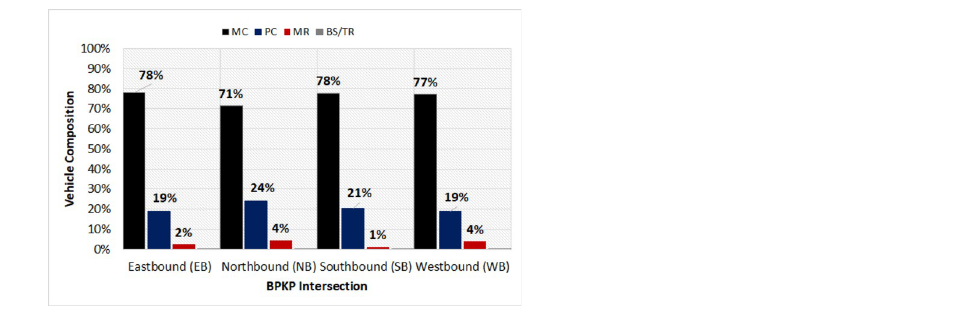
Fig 2. Vehicle composition at BPKP